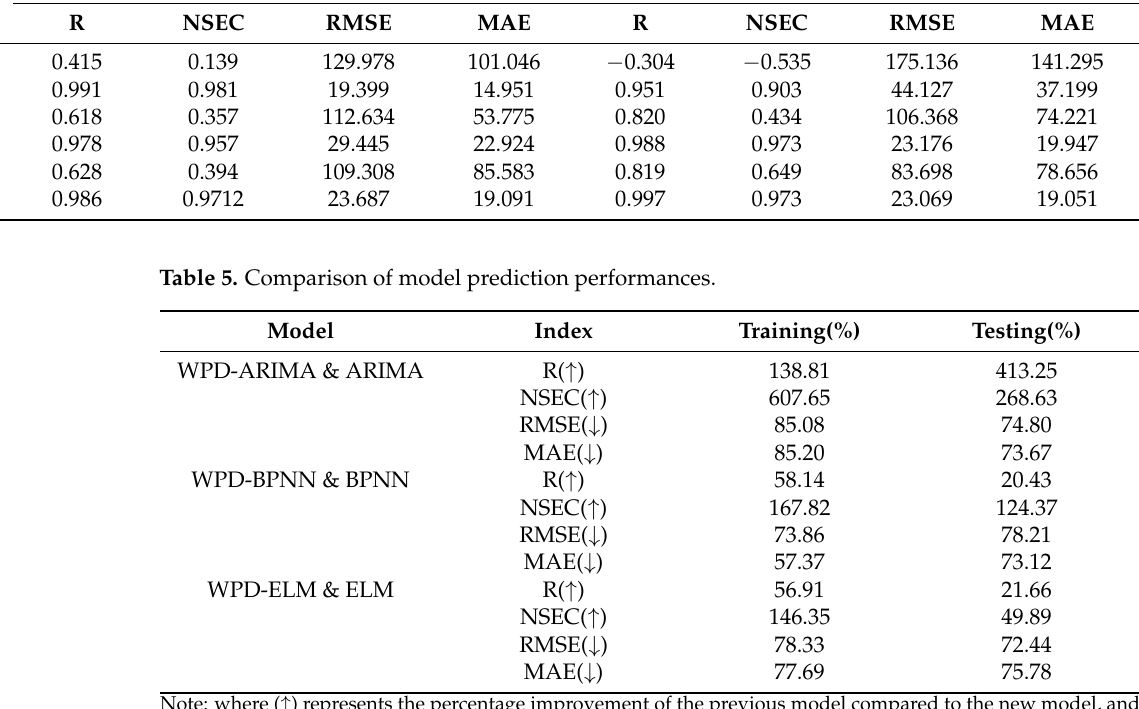
Table 4. Prediction performance of different models in training and testing phases.